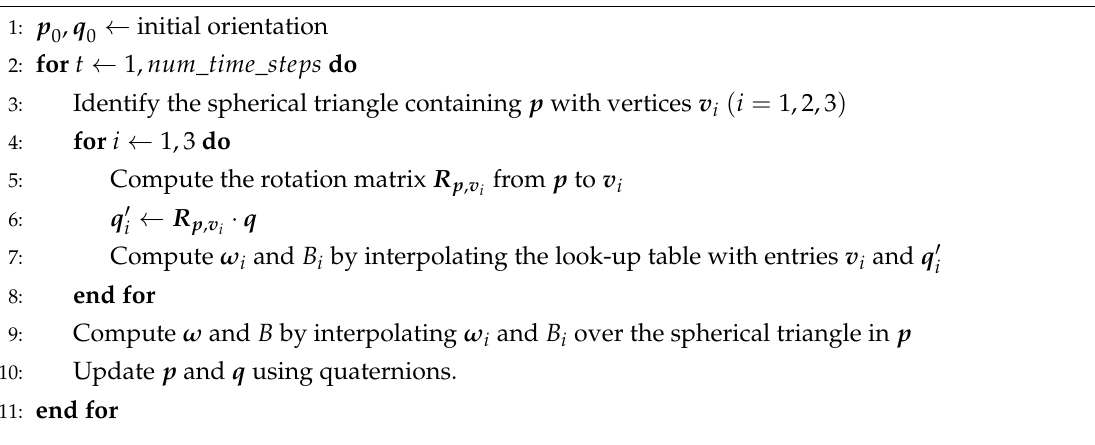
Algorithm 1 Procedure used to update the particle orientation